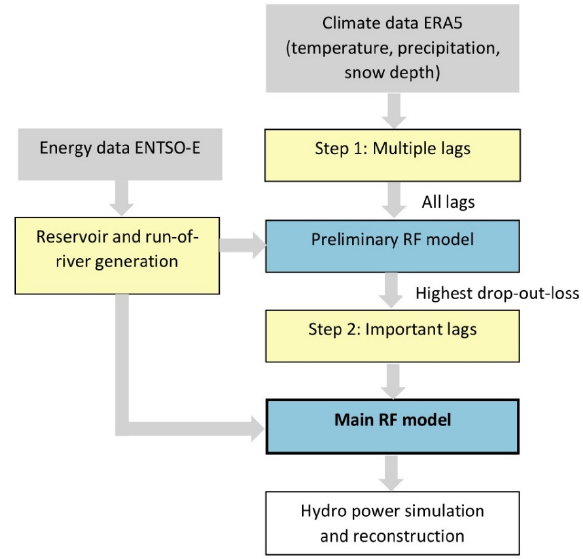
Figure 1. Processes in the two-step random forest model with multiple lags.